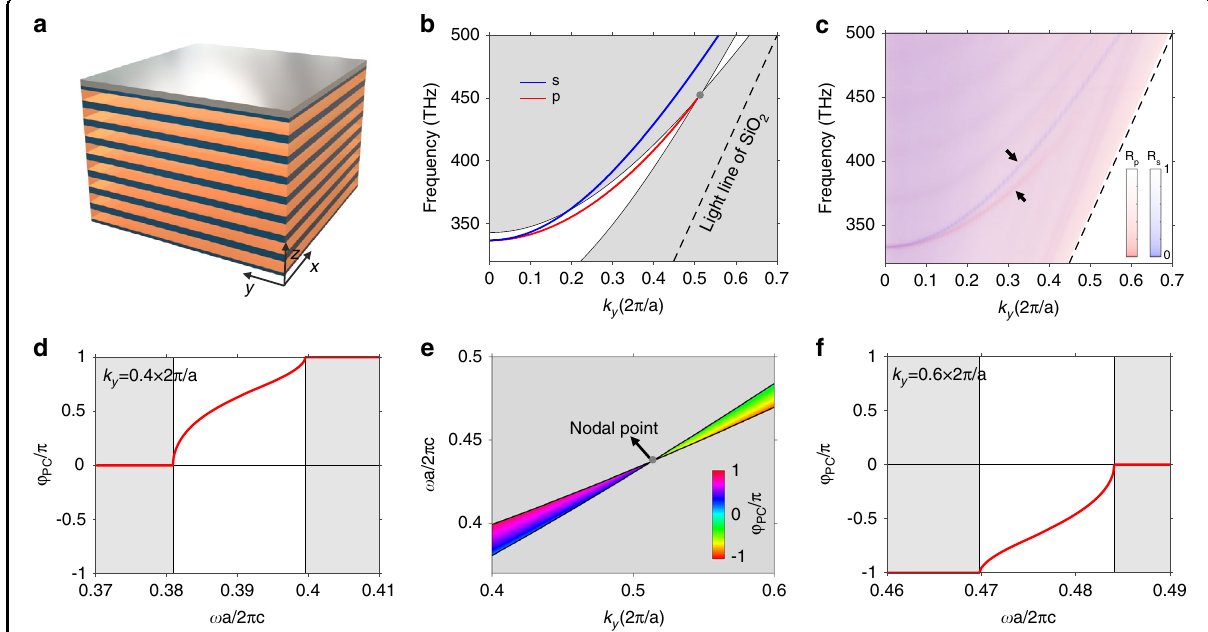
Fig. 4 Drumhead surface states of the 1D gapless NRPC. a Schematic of the interface between 1D NRPC and silver. The silver fi lm with a thickness of 40 nm is deposited on the 1D NRPC with 8 periods. b Projected band structure with s- (blue line) and p- (red line) polarized surface states. P-polarized surface states are pinned at the nodal point due to the phase winding around the nodal point. The black dashed line represents the light line of SiO 2 . c Overlaid plot of the measured angle-resolved re fl ection spectra for both polarizations. Two black arrows highlights two lines of re fl ection dips corresponding to the surface states. e Calculated p-polarized re fl ection phase ( φ PC ) of the NRPC. d , f Calculated φ PC when k y = 0.4 × 2 π / a ( d ) and k y = 0.6 × 2 π / a ( f ). Note that in the vicinity of the Dirac nodal ring, there is a 2 π phase winding around the nodal point which manifests